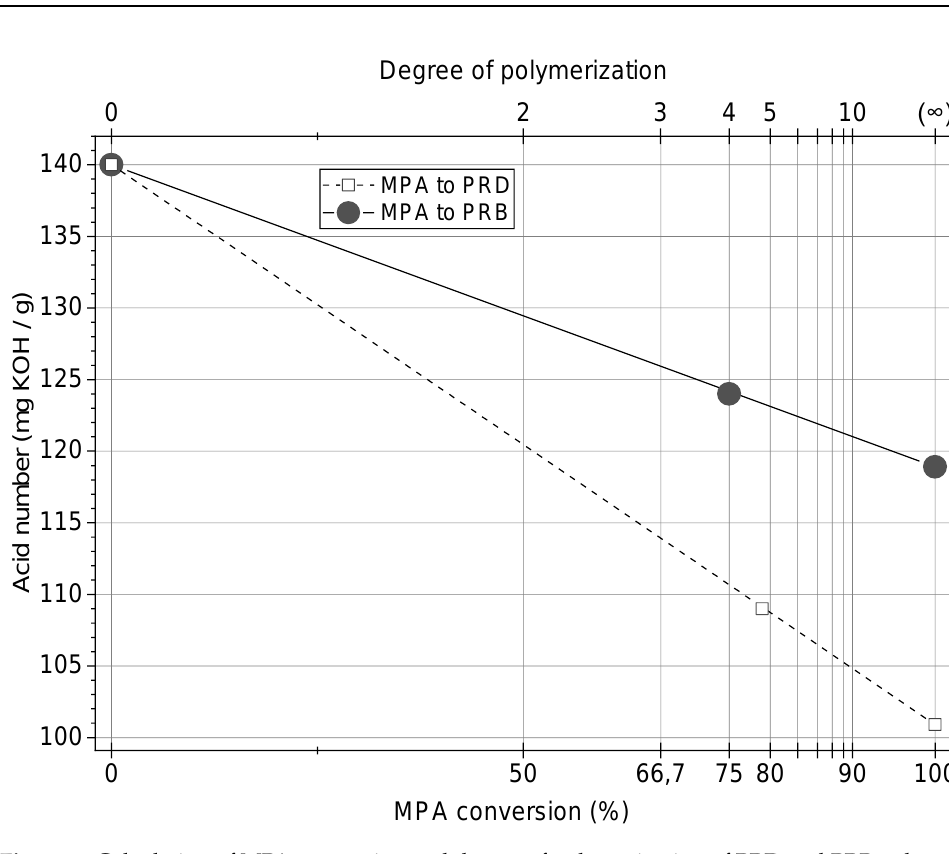
Table 2. Symbols and composition of prepared coatings and reference samples.